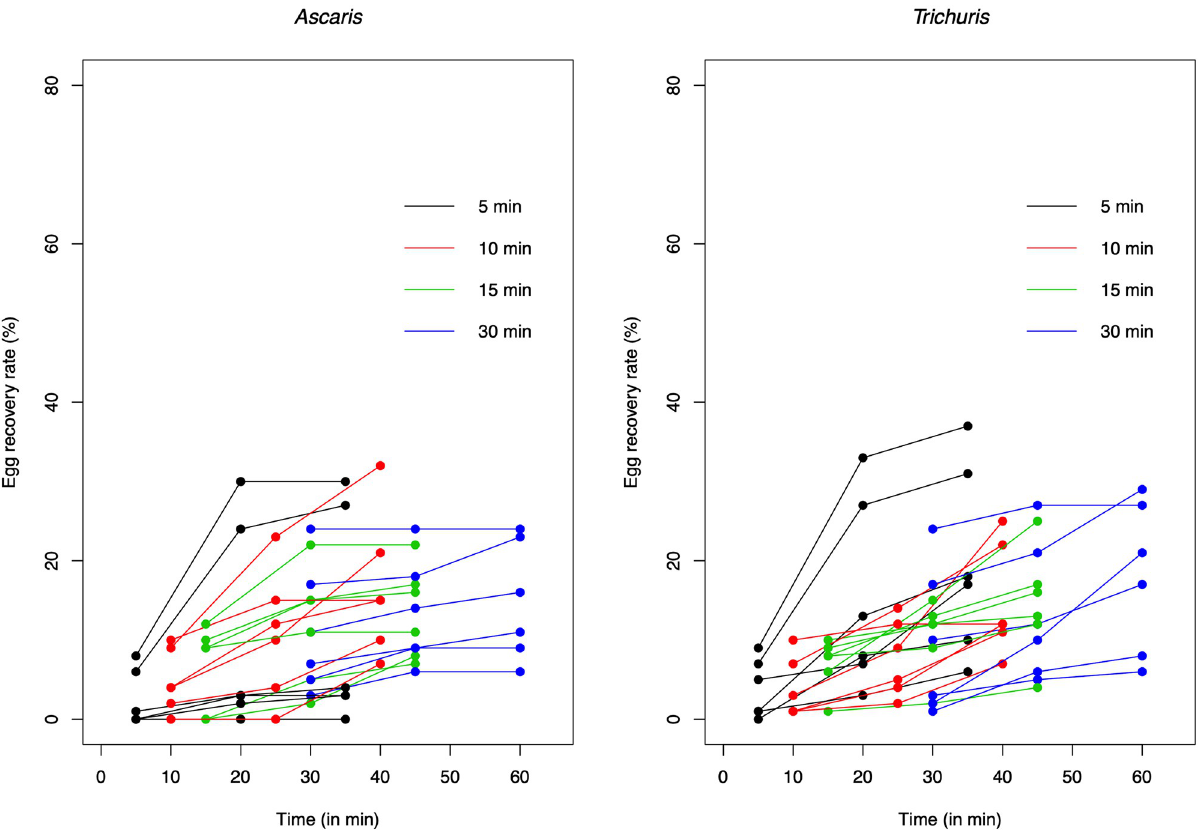
Fig 2. The recovery rate of Ascaris and Trichuris eggs following serial flotation. The spaghetti plots illustrate the cumulative egg recovery rate when serial flotation was applied. The color code differentiates the time at which the first coverslip was removed from the flotation tube.